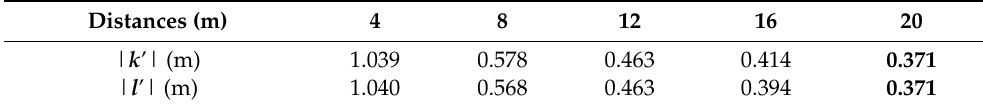
Table 4. The 2D RMSPE ∆ p (m) with varying anchor distances | k | and | l | for the NLOS